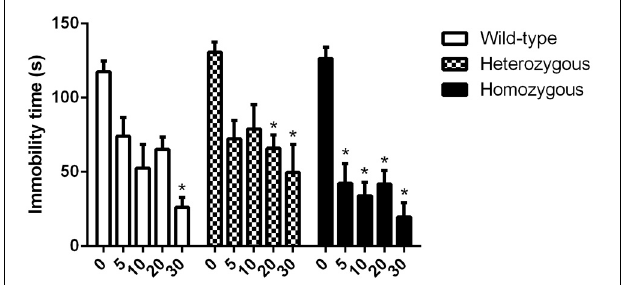
FIGURE 2 | Effect of paroxetine on the immobility time of Wfs1-deficient mice in the TST. ∗ p < 0 . 01 compared to vehicle-treated mice of the same genotype (Scheffe post-hoc test after significant Two-Way ANOVA). Altogether, 93 wild-type, 95 heterozygousand 91 homozygous mice were used. Mice were randomly divided between respective study groups. Genotype [ F ( 2 , 264 ) = 7 . 1, p < 0 . 01]; treatment [ F ( 4 , 264 ) = 41 . 4, p < 0 . 01]; genotype × treatment [ F ( 8 , 264 ) = 1 . 02, p = 0 . 42].